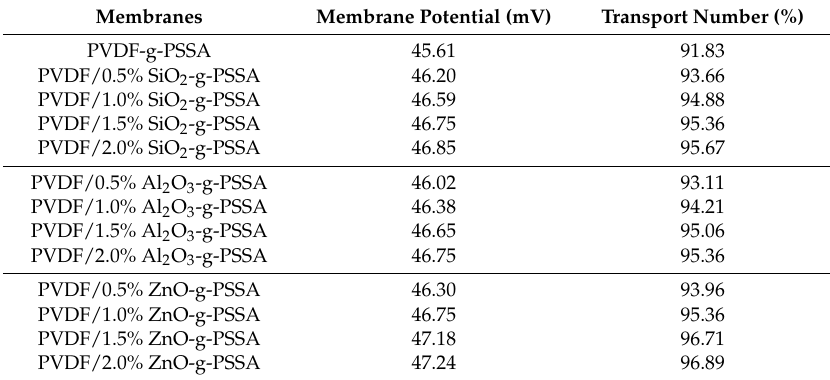
Table 1. Membrane potential and transport number values for different PVDF/X% SiO 2 /Al 2 O 3 / ZnO-g-PSSA